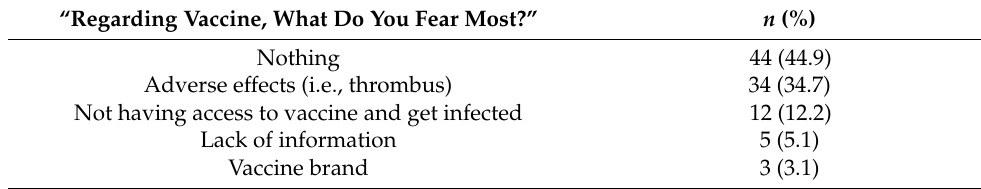
Table 2. Basal descriptive fears (N = 98) results in the total sample.